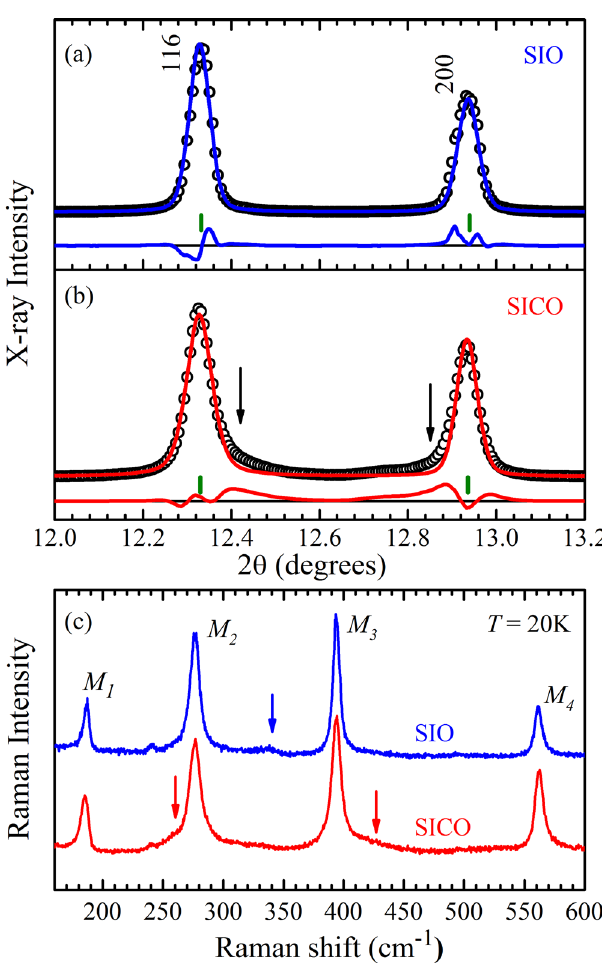
Fig. 2 Structural characterization. Selected portion of the X-ray diffraction pro fi les of Sr 2 IrO 4 (SIO, a ) and Sr 2 Ir 0.95 Co 0.05 O 4 (SICO, b ) at room temperature ( λ = 0.61986 Å ), covering the 116 and 200 Bragg re fl ections marked by the short vertical bars. The open symbols are experimental data and the solid lines are calculated pro fi les after a Rietveld re fi nement using pseudo-Voigt lineshapes for the individual Bragg peaks. The difference pro fi les are shown at the bottom of each fi gure. The vertical arrows in ( b ) highlight the asymmetric lineshape broadening. c Unpolarized Raman scattering spectra of the two investigated samples at T = 20 K. The vertical arrows highlight the presence of a peak at ~340 cm − 1 for SIO that is indicative of a stoichiometric sample 48, 49 , and extra features at ~260 and ~420 cm − 1 for SICO that are associated with weak disorder.